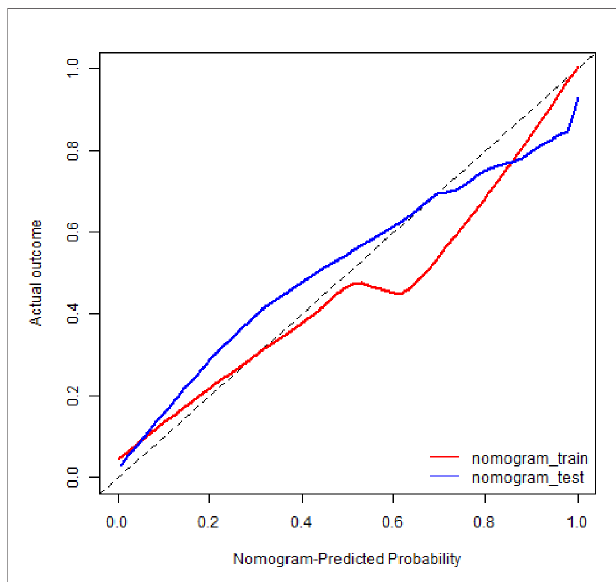
FIGURE 6 | Calibration curves of radiomics nomogram. The diagonal line represented the perfect prediction of the radiomics nomogram. The red and blue solid line represented the calibration curve of nomogram in the training and validation cohorts, separately. The calibration curves were close to the diagonal line, which indicated good prediction performance of the